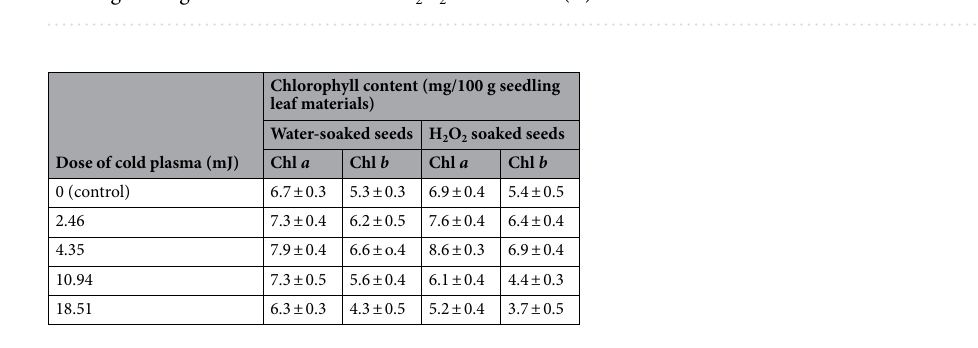
Table 3. Effect of atmospheric pressure cold plasma applied for 10 min to M. oleifera dry or soaked seeds on chlorophyll content of seedling after 30 days emerged from water soaked or H 2 O 2 soaked seeds.